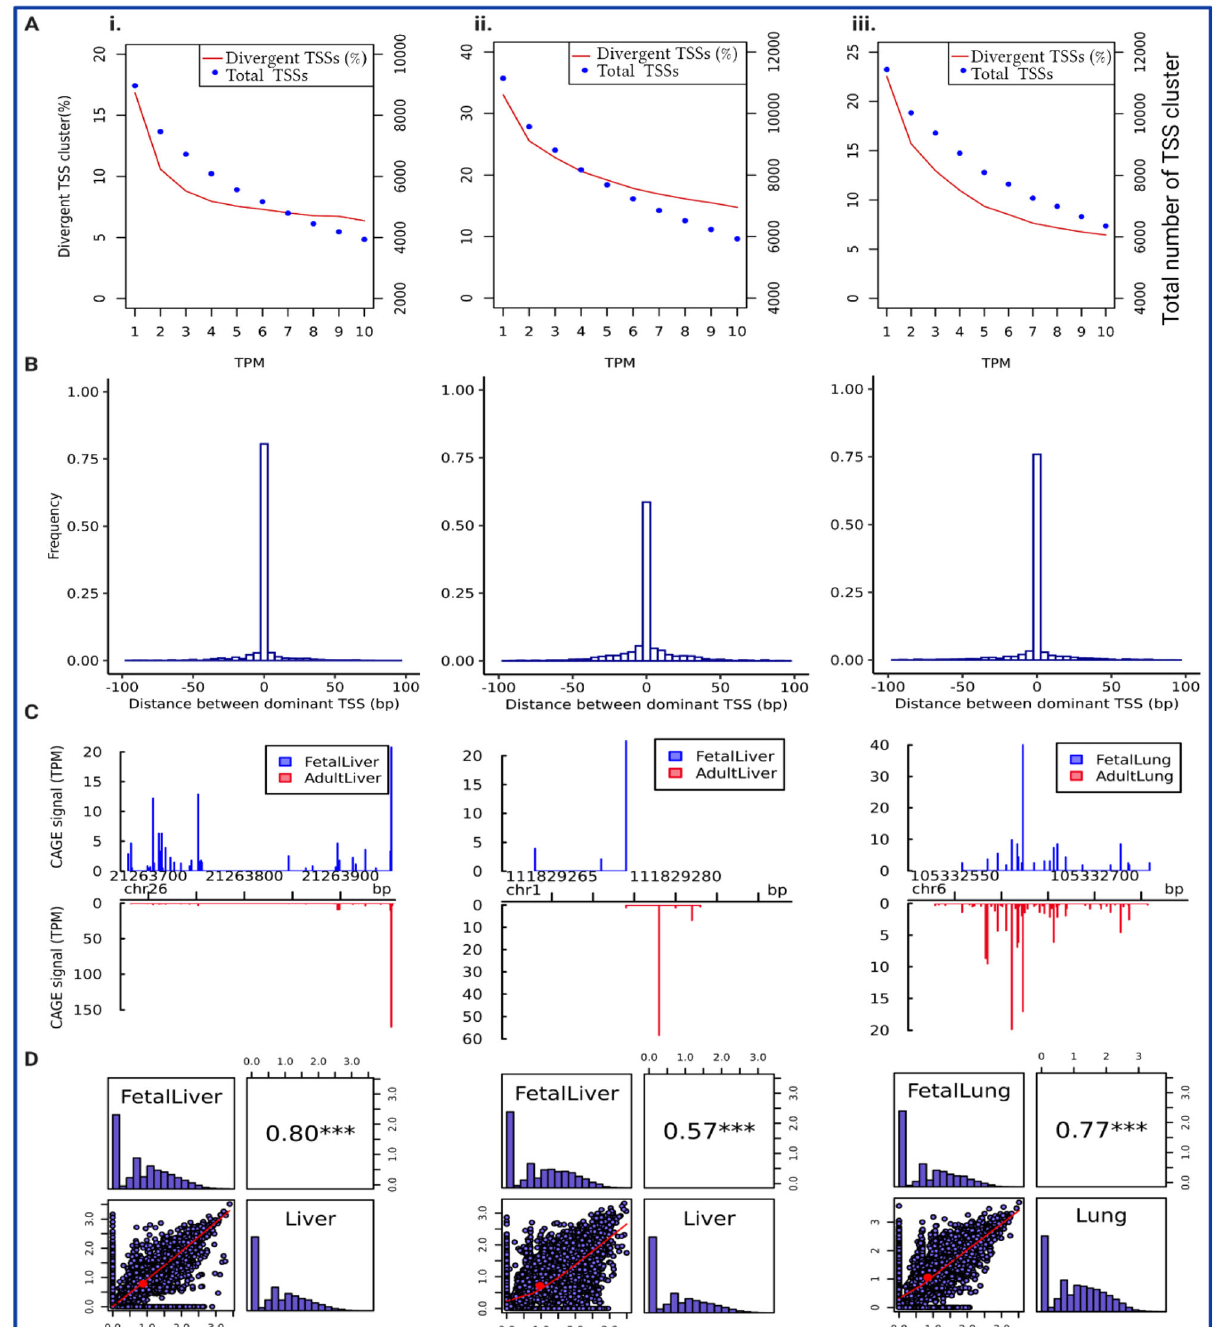
Fig. 6 Overview of comparison between fetal and adult developmental stages for Bos taurus liver (i), Bos indicus liver (ii), and Bos indicus lung (iii). A Total number of TSS clusters and their percentage of divergent TSS clusters at different expression levels (TPM), B Histogram of distances between fetal and adult dominant TSS in consensus TSS clusters with at least 10 TPM level expression, and C An example of differential TSS usage observed in gene SCD in Bos taurus liver (shifting score 0.56), SLC33A1 in Bos indicus liver (shifting score 0.92) and WDR1 in Bos indicus lung tissue (shifting score 0.26) across two developmental stages (FDR P -value < 0.05). Shifting score is a measure of differential usage of TSSs within consensus cluster between two developmental stages, which indicates the degree of physical separation of TSSs used within given consensus TSS cluster. The annotated TSS based on the Ref-Seq gene using Apr.2018 (ARS-UCD1.2/bosTau9) for genes SCD, SLC33A1, WDR1 located at positions (21,263,976), (111,829,274), (105,332,584), respectively. D Pearson correlation of TSS diversity measured by Shannon index (the distribution of Shannon index is shown on the diagonal and on the bottom of the diagonal the bivariate scatter plots with a fi tted line are displayed. Also, on the top of the diagonal, the value of the correlation plus the signi fi cance level ( P -value < 0.001) as stars is